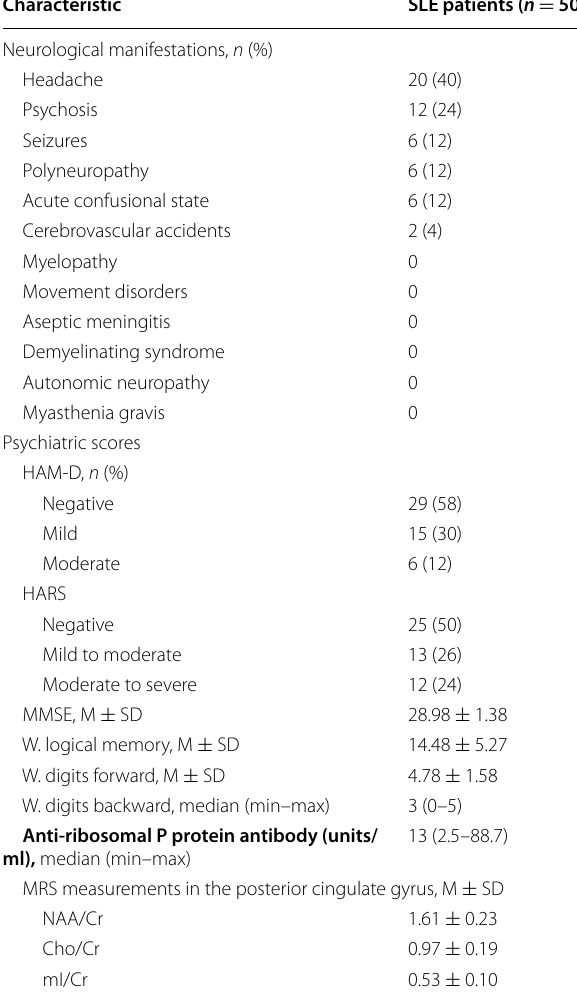
Table 2 Neuropsychiatric manifestations, anti‑ribosomal P protein level, and brain MRS findings in the study SLE patients ( n =